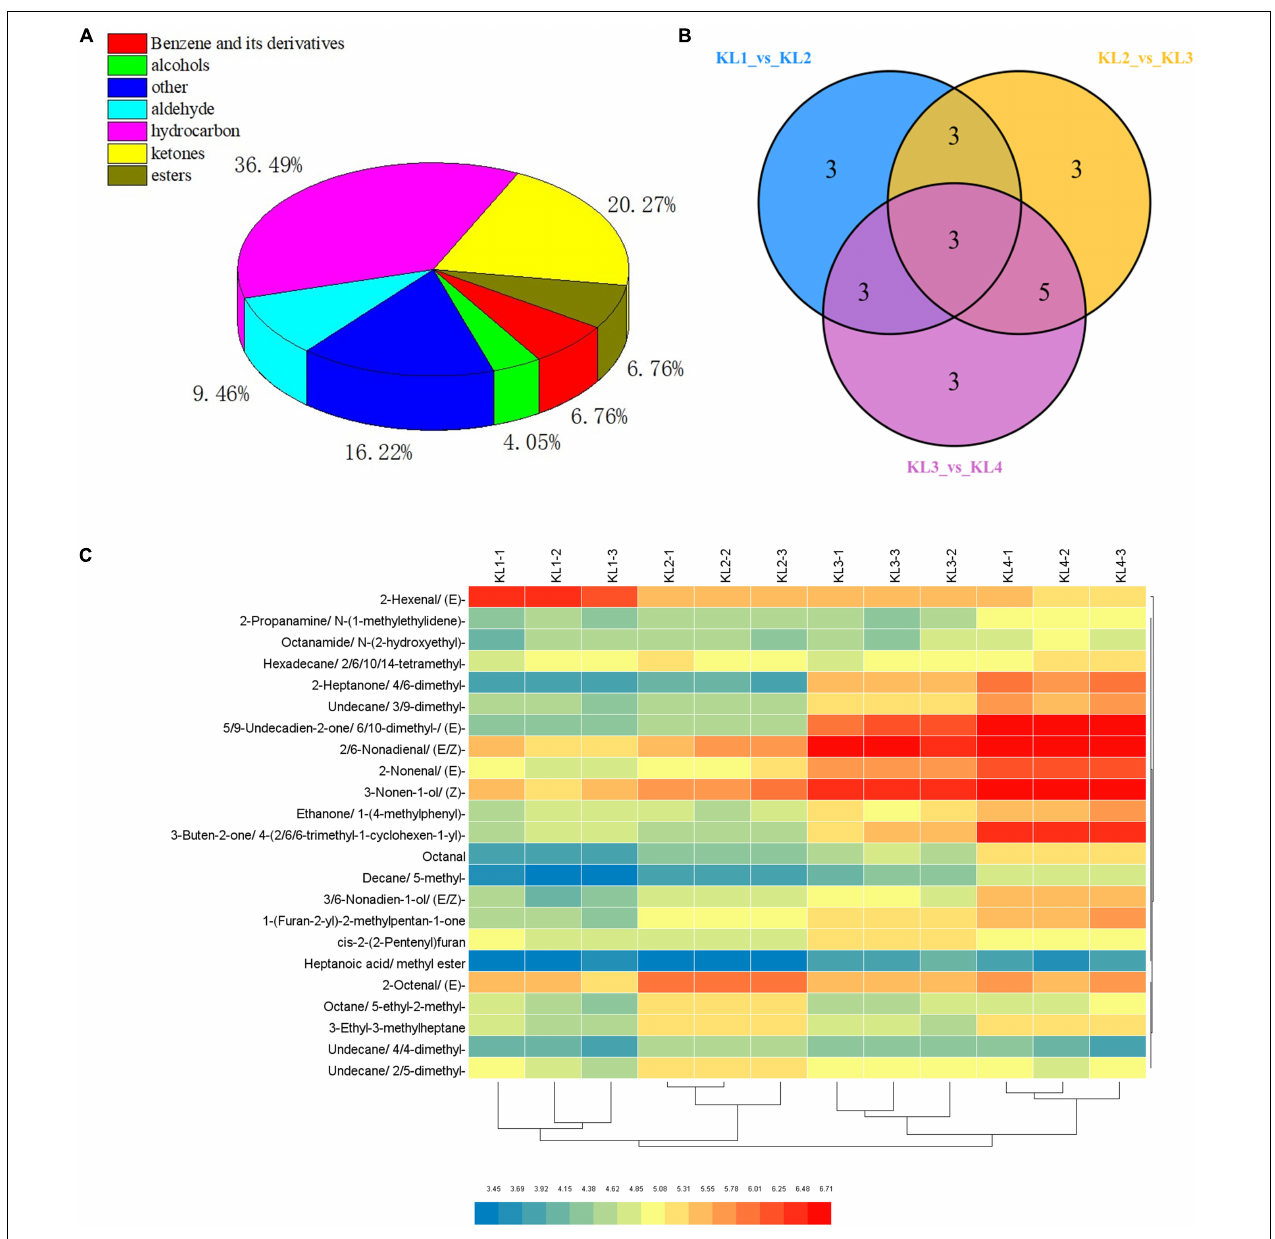
FIGURE 3 | Classification of volatile organic compounds (VOCs) detected by GC–MS and analysis of differential metabolites. (A) Pie chart of the classification of 74 VOCs. (B) Venn diagram of the number of differential accumulation VOCs by comparing KL1 vs. KL2, KL2 vs. KL3, and KL3 vs. KL4. (C) Hierarchical clustering heat map of 23 differential accumulation VOCs in 12 samples, KL1, KL2, KL3, and KL4 represent the samples at 10, 18, 26, and 34 DAP, and -1, -2, and -3 represent different samples from the same